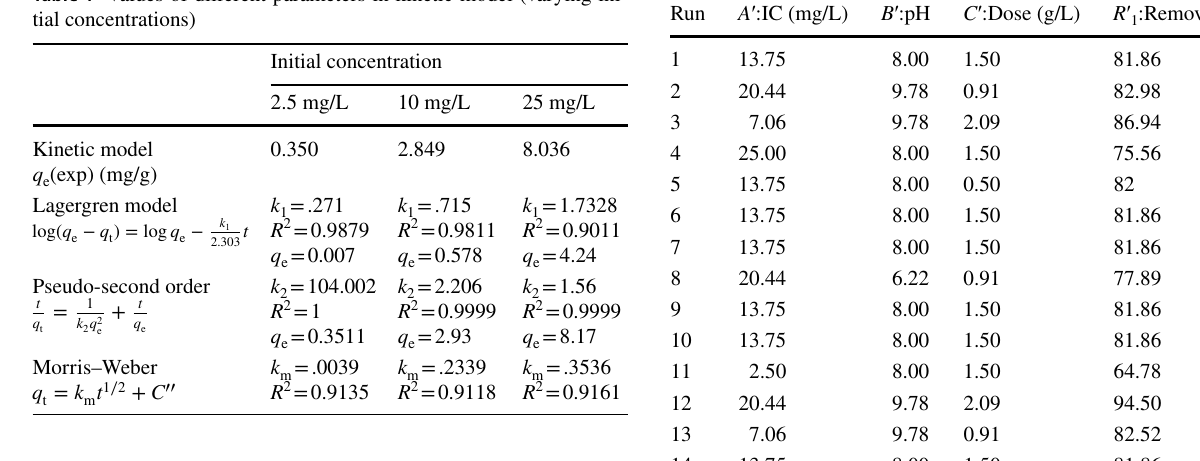
Table 5 The experimental design obtained from